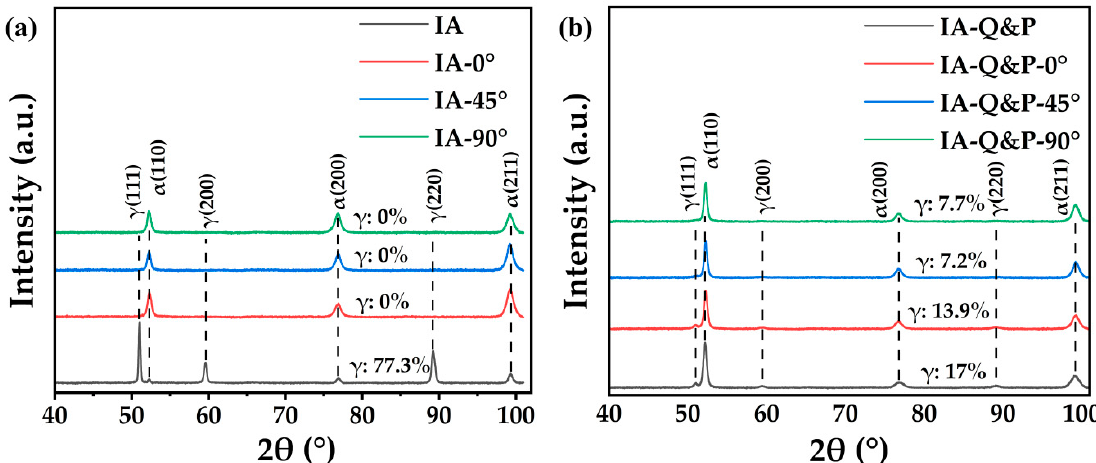
Figure 5. The XRD profiles of ( a ) the IA steel and ( b ) the IA-Q&P steel prior to and after the tensile test along different tensile directions (0 ◦ , 45 ◦ , 90 ◦ ). The measurement was performed at the uniformly deformed region.